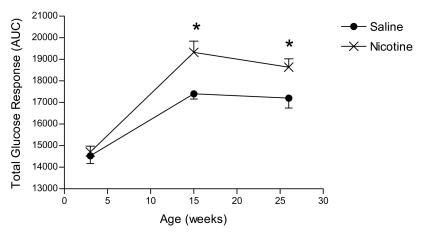
Oral glucose tolerance tests during postnatal development.Area under the curve (AUC) for the total glucose response to an oral glucose challenge at 4, 15 and 26 weeks of age in saline (closed circles) and nicotine-exposed (open circles) animals. All data are presented as mean±SEM. Values with an asterisk are significantly (p<0.05) different from saline controls.